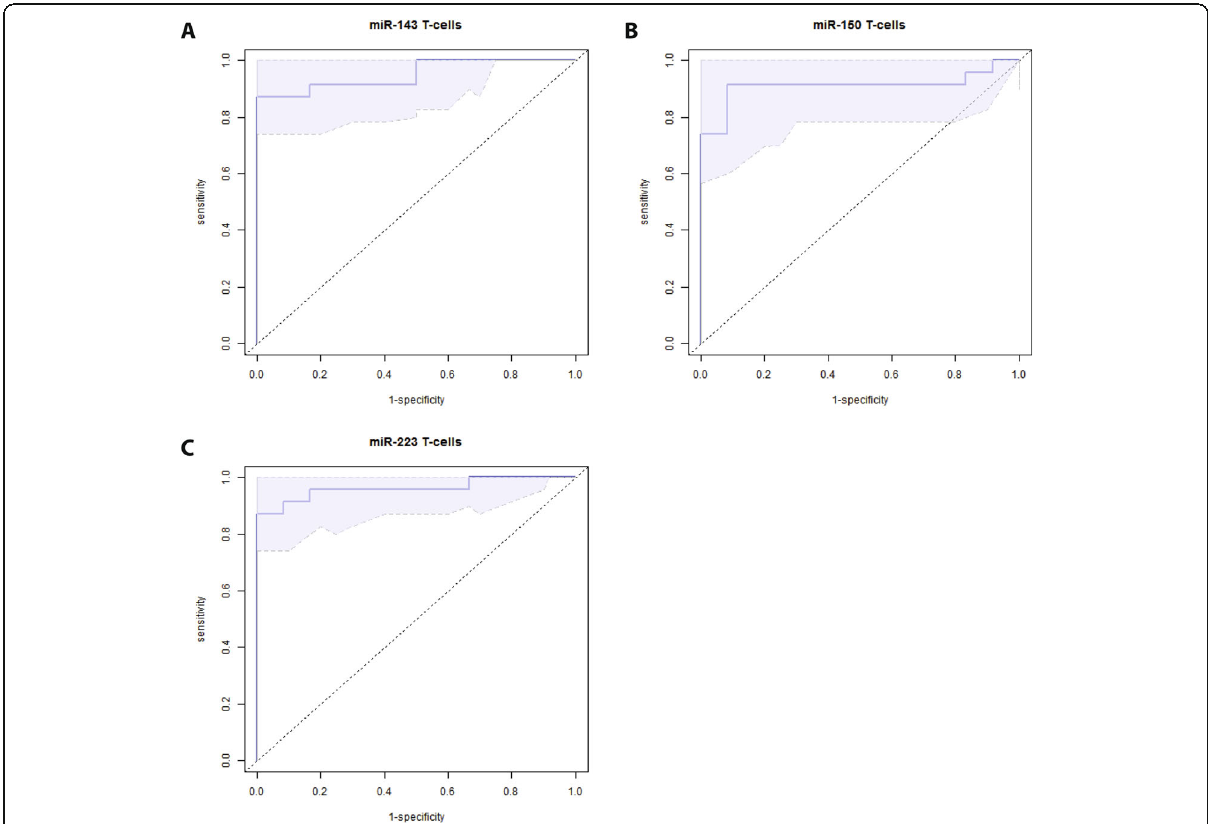
Fig. 3 Discriminatory power of miR-143, miR-150 and miR-223 in T-cells. Predictive modeling and Area-under-the-ROC-curve generation. Candidate miRNAs were selected for predictive modeling: ( a ) miR-143, ( b ) miR-150 and ( c ) miR-223 in T-cells of septic patients as compared to healthy controls, n =10/20 (NC/Sepsis). The shadowed areas denote the confidence interval for the area under the